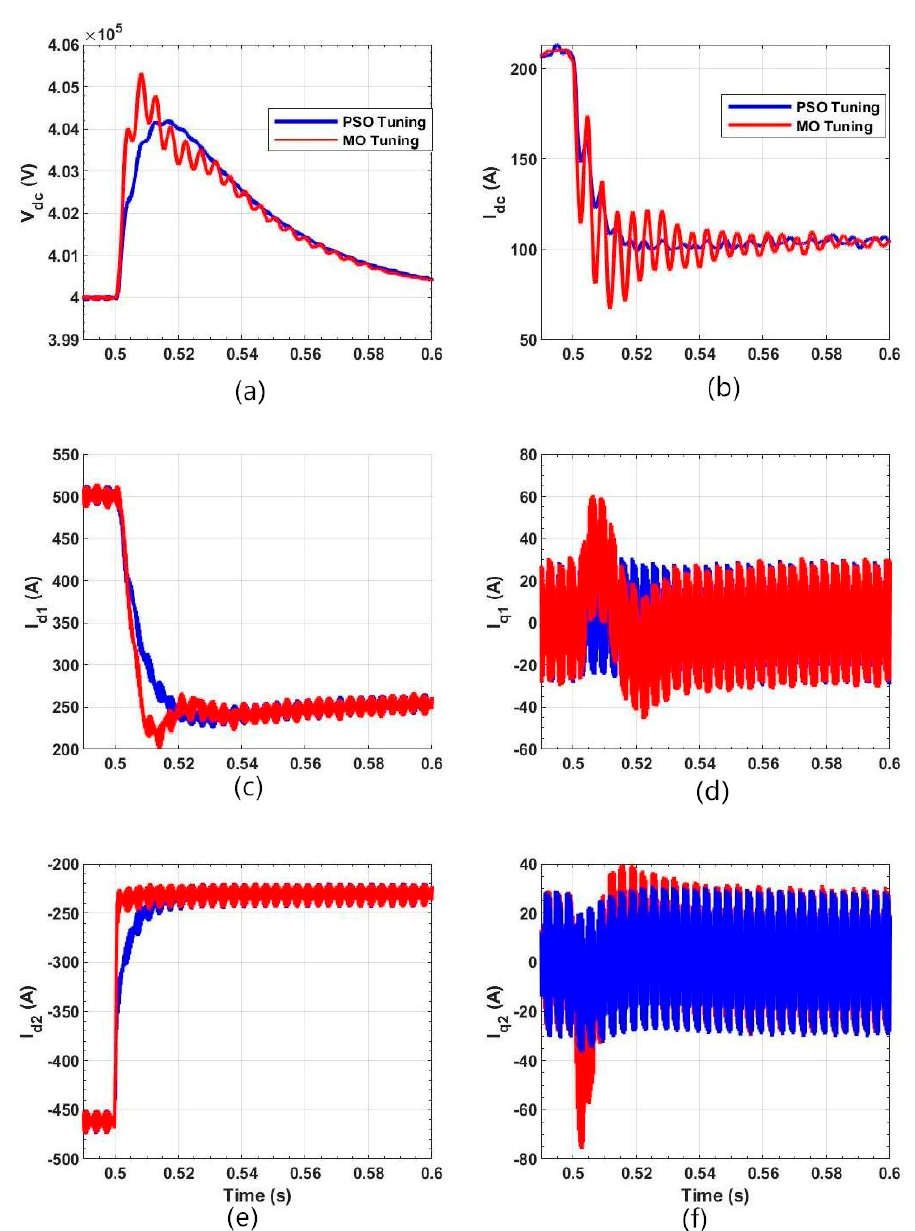
Figure 5. Comparison between PSO and modulus optimum (MO) tuning methods for 50% step change active power. ( a ) DC link Voltage ( b ) DC link current ( c ) d axes current for conv-1 ( d ) q axes current for conv-1 ( e ) d axes current for conv-2 ( f ) q axes current for conv-2.